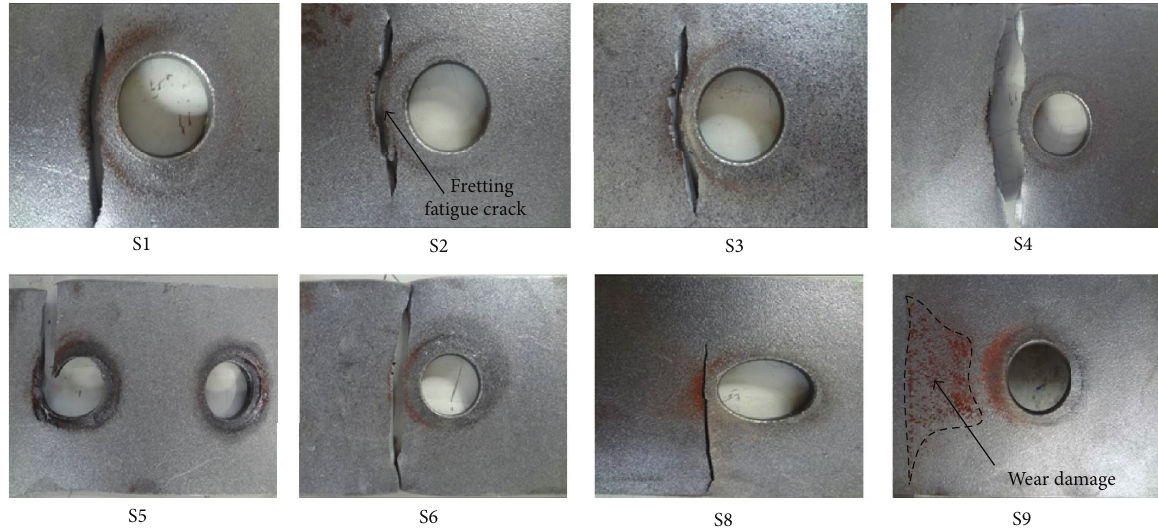
Figure 4: Illustration of fatigue fracture surfaces and fretting damage at the contact